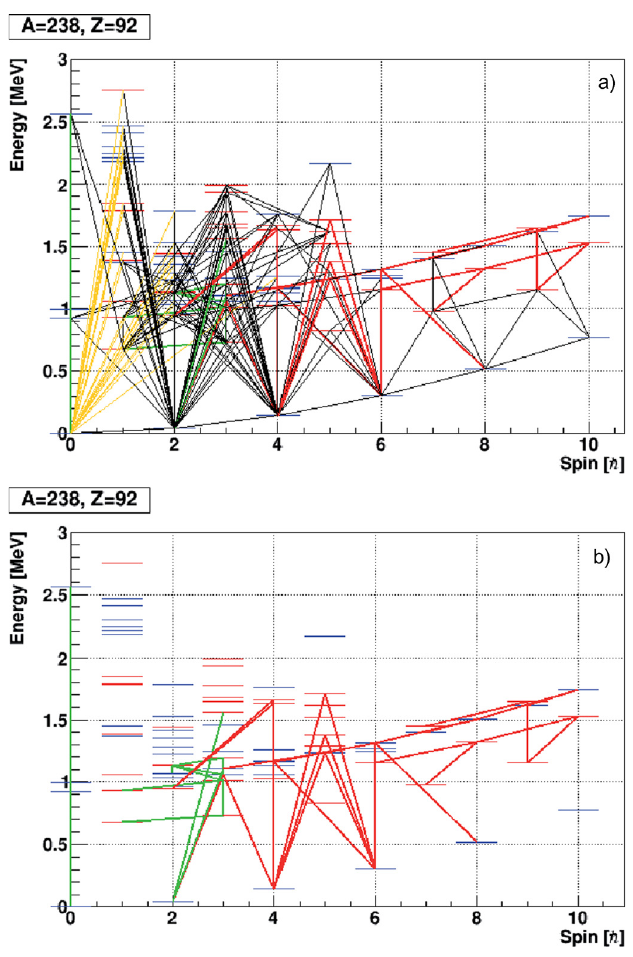
Fig. 7. Portion of the 238 U spin-excitation energy plan, see text for